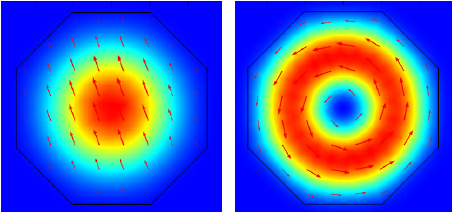
Figure 4. Intensity profiles of HE 11 ( left ) and TE 01 ( right ) modes in an untwisted octagon-shaped core fiber with R = 25 μm, NA = 0.065 and λ = 1064 nm.